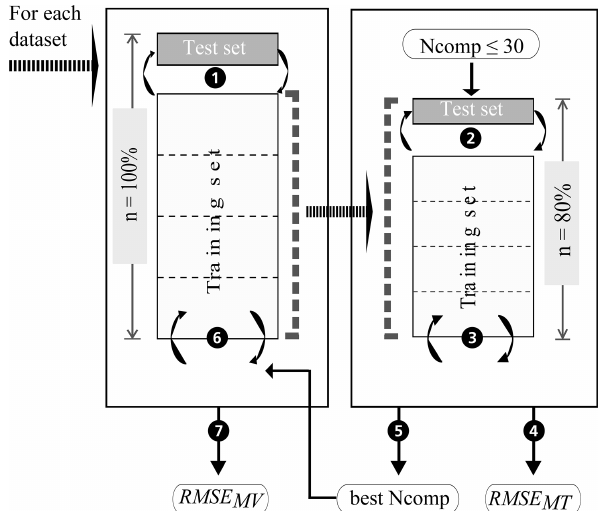
Figure 6. Model tuning and model validation procedure with a nested k -fold group CV approach. The right box shows the model tuning, the left one the model validation procedure; Ncomp in- dicates the number of components; adapted from Guio Blanco et al. (2018).